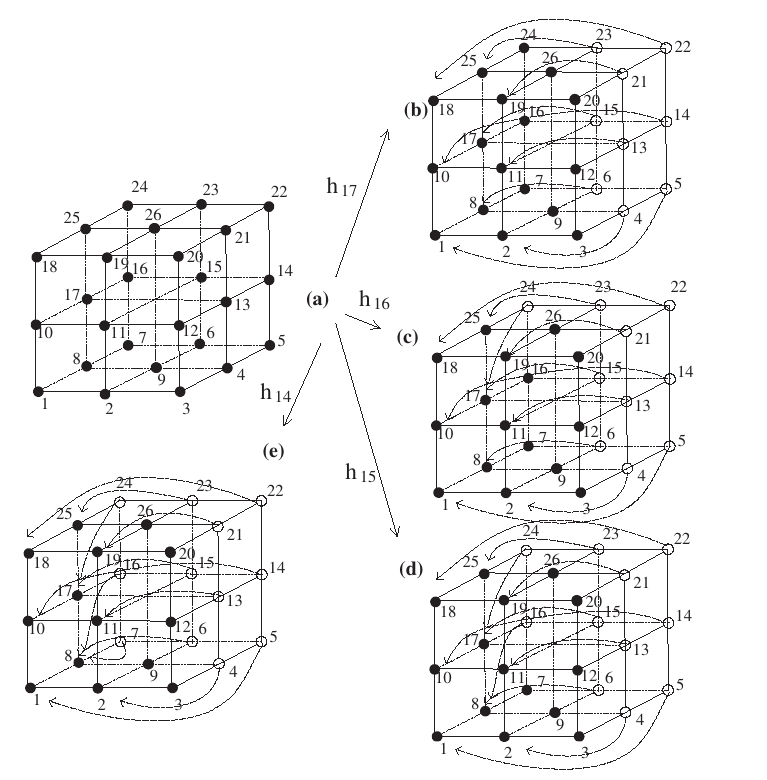
Figure 4. Configuration of 6-continuous self-maps h i of MSS 6 such that Fix ( h i ) (cid:93) = i , i ∈ [ 0,17 ] Z . ( a ) MSS 6 . ( b ) The image by the self-map h 17 of MSS 6 . ( c ) The image by the self-map h 16 of MSS 6 . ( d ) The image by the self-map h 15 of MSS 6 . ( e ) The image by the self-map h 14 of MSS 6 . This functions support the maps in the proof of Theorem